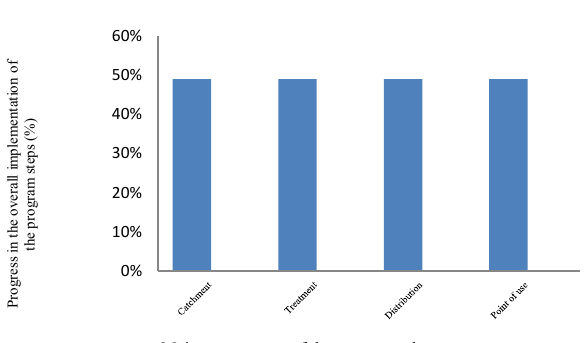
Fig. 3. Results by